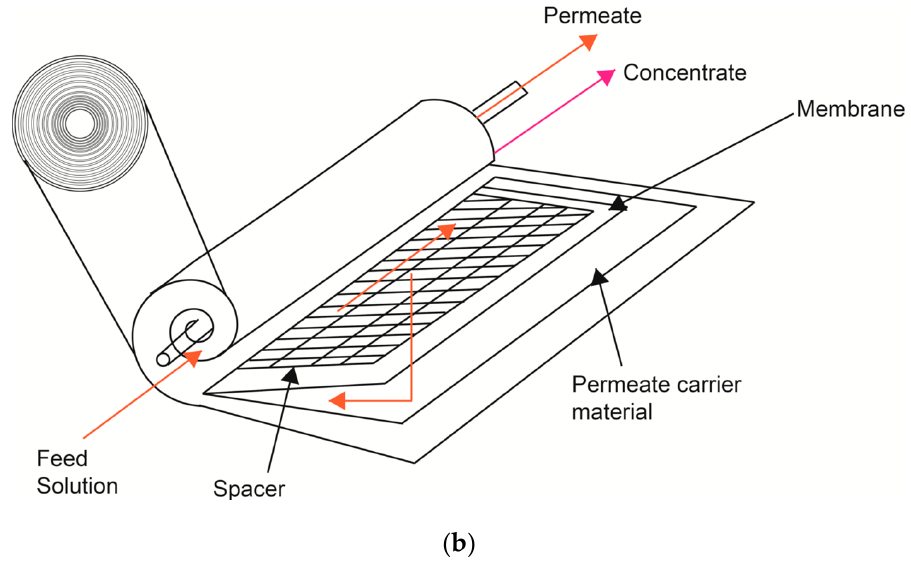
Figure 2. Schematic diagram of tubular ceramic membrane ( a ) and polymeric spiral-wound membrane ( b ). Table 1. Characteristics of tight ultrafiltration membranes used.